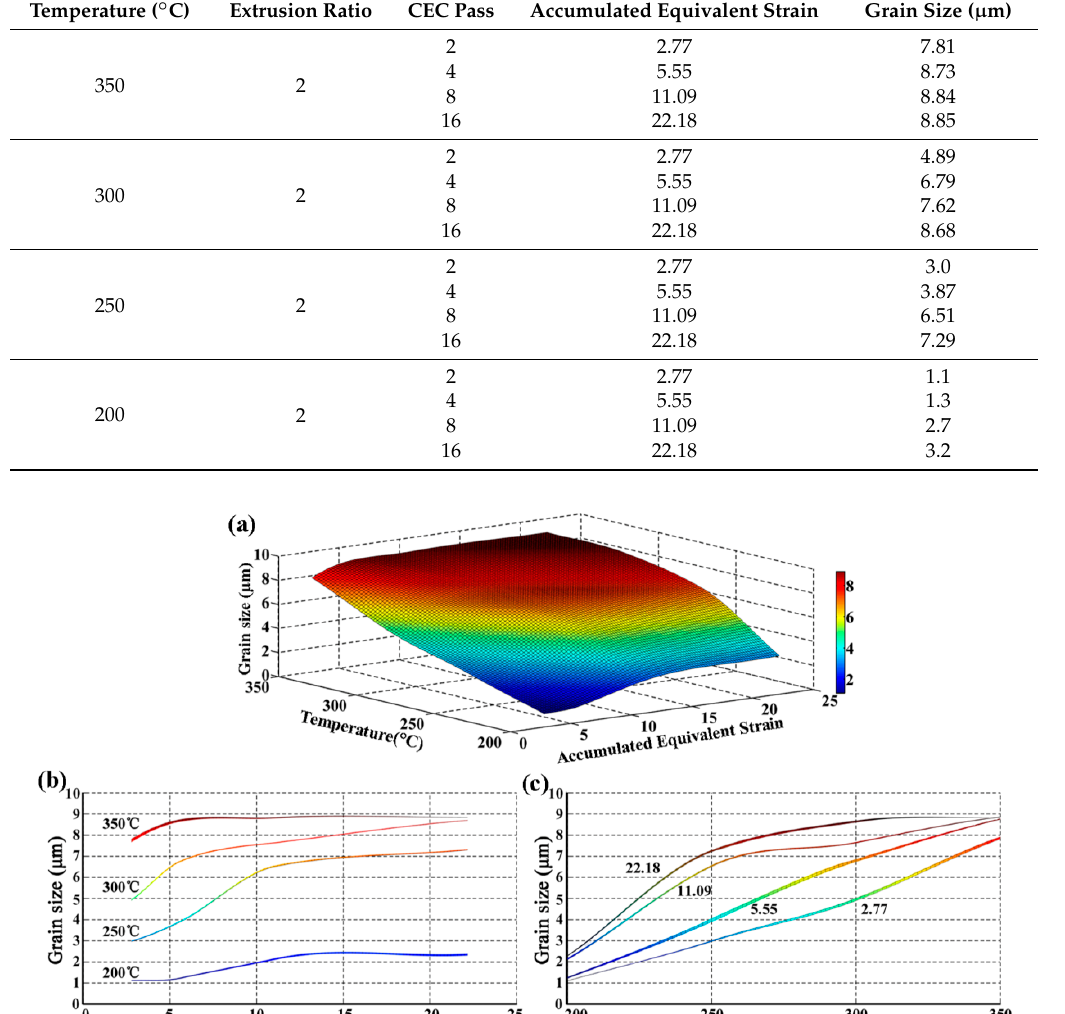
Table 1. Summarized parameters of CEC for as-extruded ZK61 alloy rods.